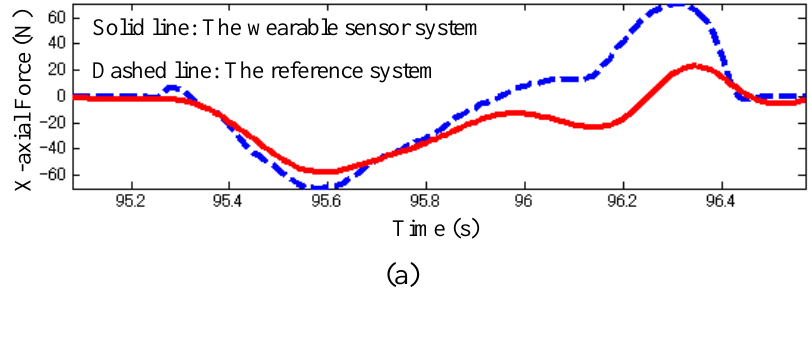
Figure 3. Triaxial GRF measured by the wearable sensor system (solid line) and referenced system (dashed line) during walking trial. (a) Comparison results of x-axial force (anterior-posterior direction); (b) Comparison results of y -axial force (medio-lateral direction); (c) Comparison results of z -axial force (vertical